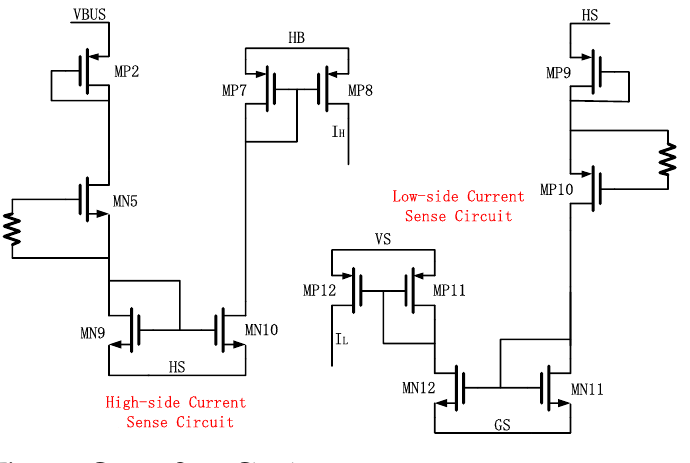
Figure 6. Current Sense Circuit.